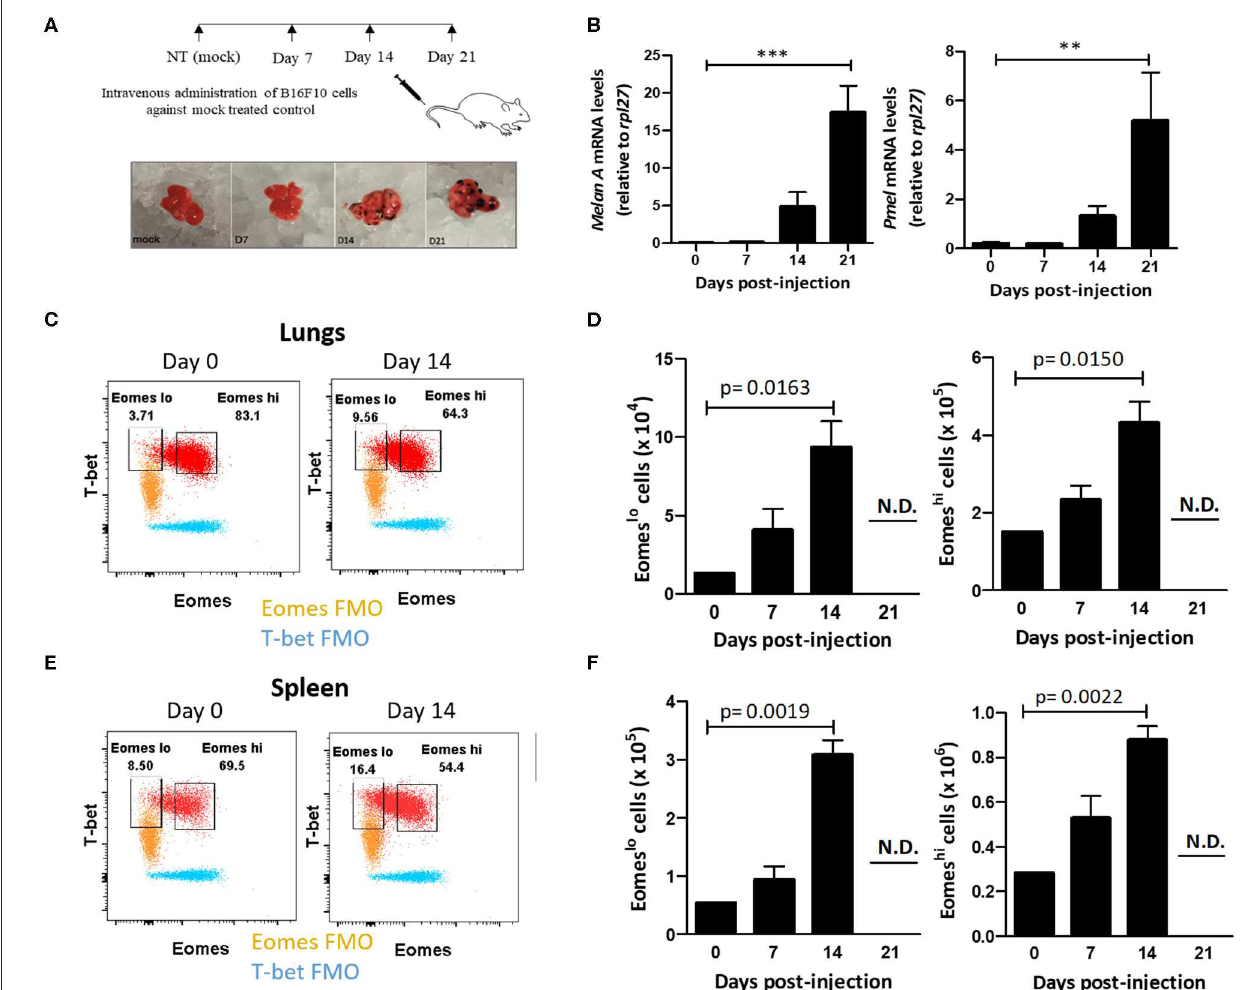
FIGURE 2 | Eomes lo Group 1 ILCs accumulate in the lung during B16F10 metastatic progression. (A) Schematic for setting up B16F10 murine metastatic melanoma study model in B6 mice. Mice were sacrificed and lungs were harvested at various time points. (B) Quantification of tumour burden in the lungs using melanocyte-specific genes Melan-A and Pmel relative to Rpl27 housekeeping gene. (C) Identification and representative flow plot of pulmonary Eomes lo and Eomes hi cells in the lung at day 0 and day 14. (D) Quantification of Eomes lo and Eomes hi cell numbers with increase in metastatic burden in the lungs. Both these cell subsets were not detectable (N.D.) at day 21. (E) Identification and representative flow plot of splenic Eomes lo and Eomes hi cells at day 0 and day 14. (F) Increase in splenic Eomes lo and Eomes hi numbers with increase in metastasis. Both these cell subsets were not detectable (N.D.) at day 21. Cell populations were gated over NKp46 + NK1.1 + CD45.2 + live Group 1 ILCs for (C–F) . For (C,E) , FMO controls are overlaid. MFI is Mean Fluorescence Intensity, n = 4 for each group. Data are representative of three independent repeats; Data are presented as mean ± s.e.m.; statistical significance was tested using one-way ANOVA (B) two-tailed